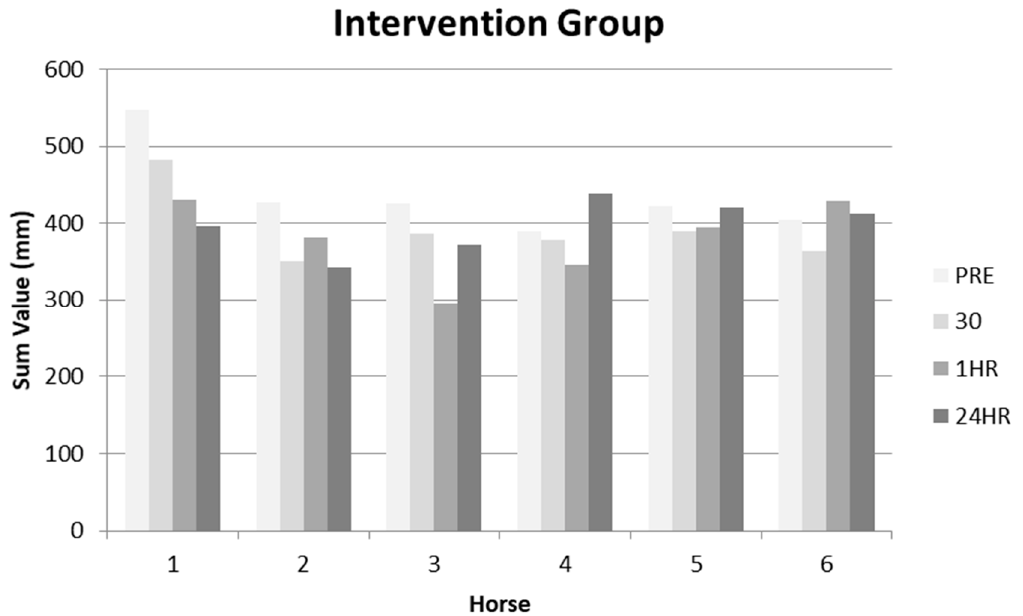
Figure 3. Summed data for the intervention group at time periods: before (PRE), thirty minutes, one hour and twenty ‐ four hours after DME.